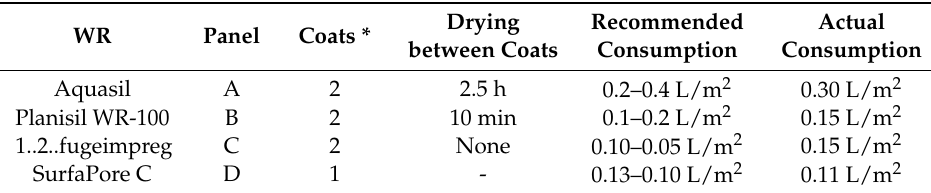
Table 4. Application of